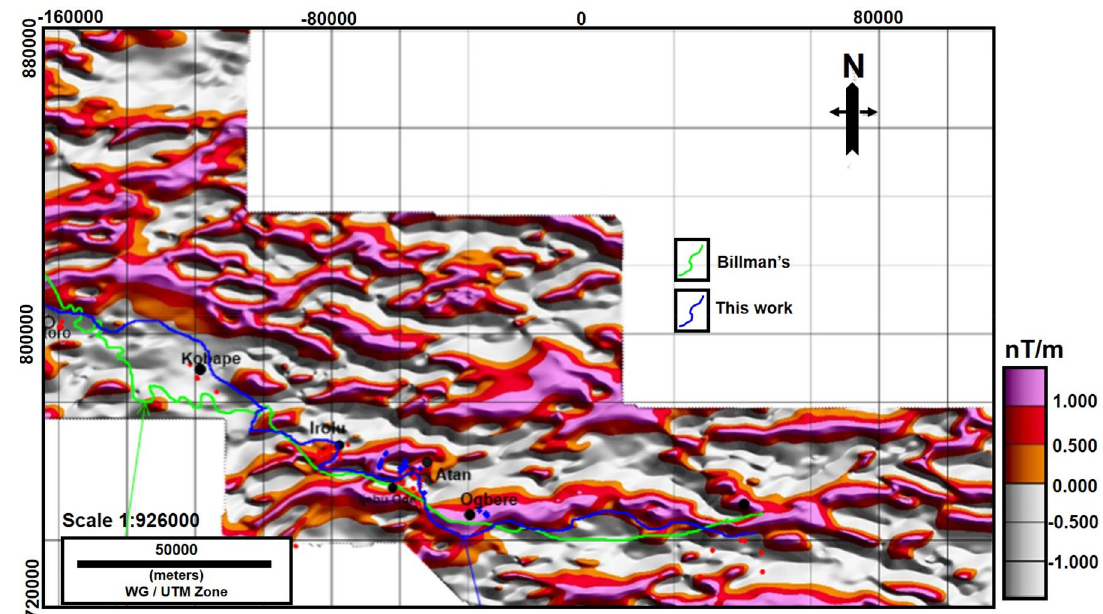
Figure 5. TDR Map with the geologic boundary from 36 in green and the newly proposed boundary from this work. The red points are inferred sedimentary rocks while the blue points are inferred basement rocks. In addition, the VES points interpreted as basement and sedimentary rocks are overlain on the map. Note: The figure was made using Oasis Montaj software (https ://www.seequ ent.com/produ cts-solut ions/geoso ft-oasis -monta j/) and edited in CorelDRAW2017, https ://www.corel .com/en/.